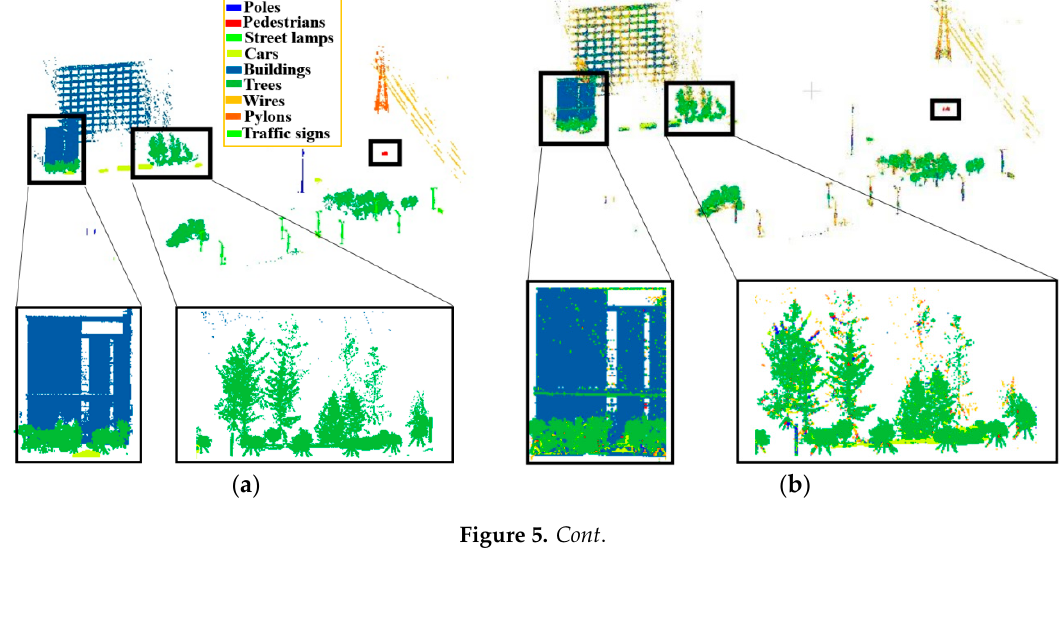
Table 7. Classification results of Scene 5(%). F 1 -score corresponds to the accuracy in terms of pedestrians / trees / cars / buildings. Note that the highest accuracy values are highlighted in bold.